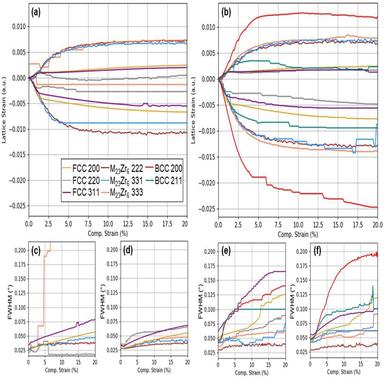
Statistical model results for the main FCC, M23Zr6 and BCC peaks for both alloys compressed at RT, showing the evolution of the lattice strain of the axial and radial integration for A4Z3 (a) and A9Z2 (b); the evolution of the FWHM for A4Z3 axial (c), A4Z3 radial (d), A9Z2 axial (e), and A9Z2 radial (f). The results indicate signs of misfit and loss of track of the model for: A4Z3 FCC 220 axial and radial, M23Zr6 331 axial and 333 axial, and for A9Z2 BCC 211 axial. For colors, please see digital version.